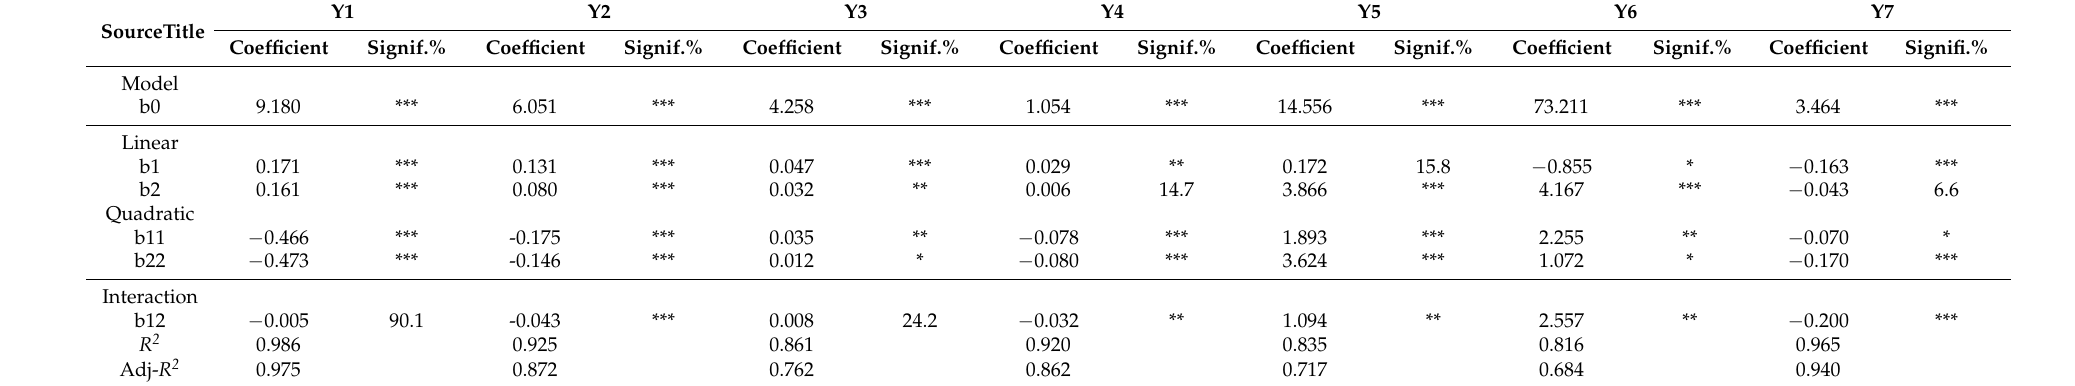
Table 3. Analysis of variance for each response Y1 (lactic acid bacteria cells count), Y2 (yeasts cell count), Y3 (pH), Y4 (TTA), Y5 (TPC), Y6 (DPPH radical scavenging activity), and Y7 (OA) (linear, quadratic and